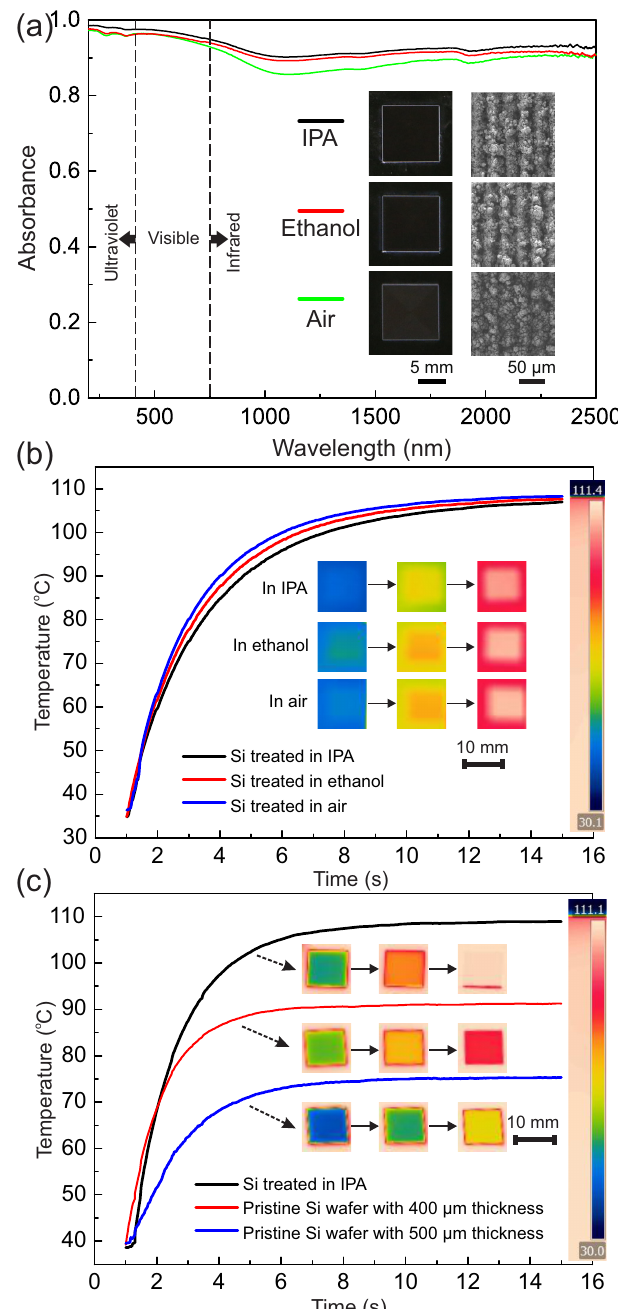
Figure 4. Light absorbance and heat transfer features of the treated Si samples. ( a ) Light absorbance of three Si samples in the 200–2500 nm range. All these three samples were treated with the same parameters of v = 15 mm/s and Δ L = 0.03 mm but in different atmospheres of IPA (the black curve), ethanol (the red curve), and air (the green curve). ( b – c ) Temperature measurement during the heating process: ( b ) comparison curves of the three Si samples treated in IPA, ethanol, and air; ( c ) comparison curves of the treated Si samples with an original thickness of 500 μ m, the pristine Si wafer with a thickness of 400 μ m, and the pristine Si wafer with a thickness of 500 μ m. All samples had an area of 10 × 10 mm 2 .